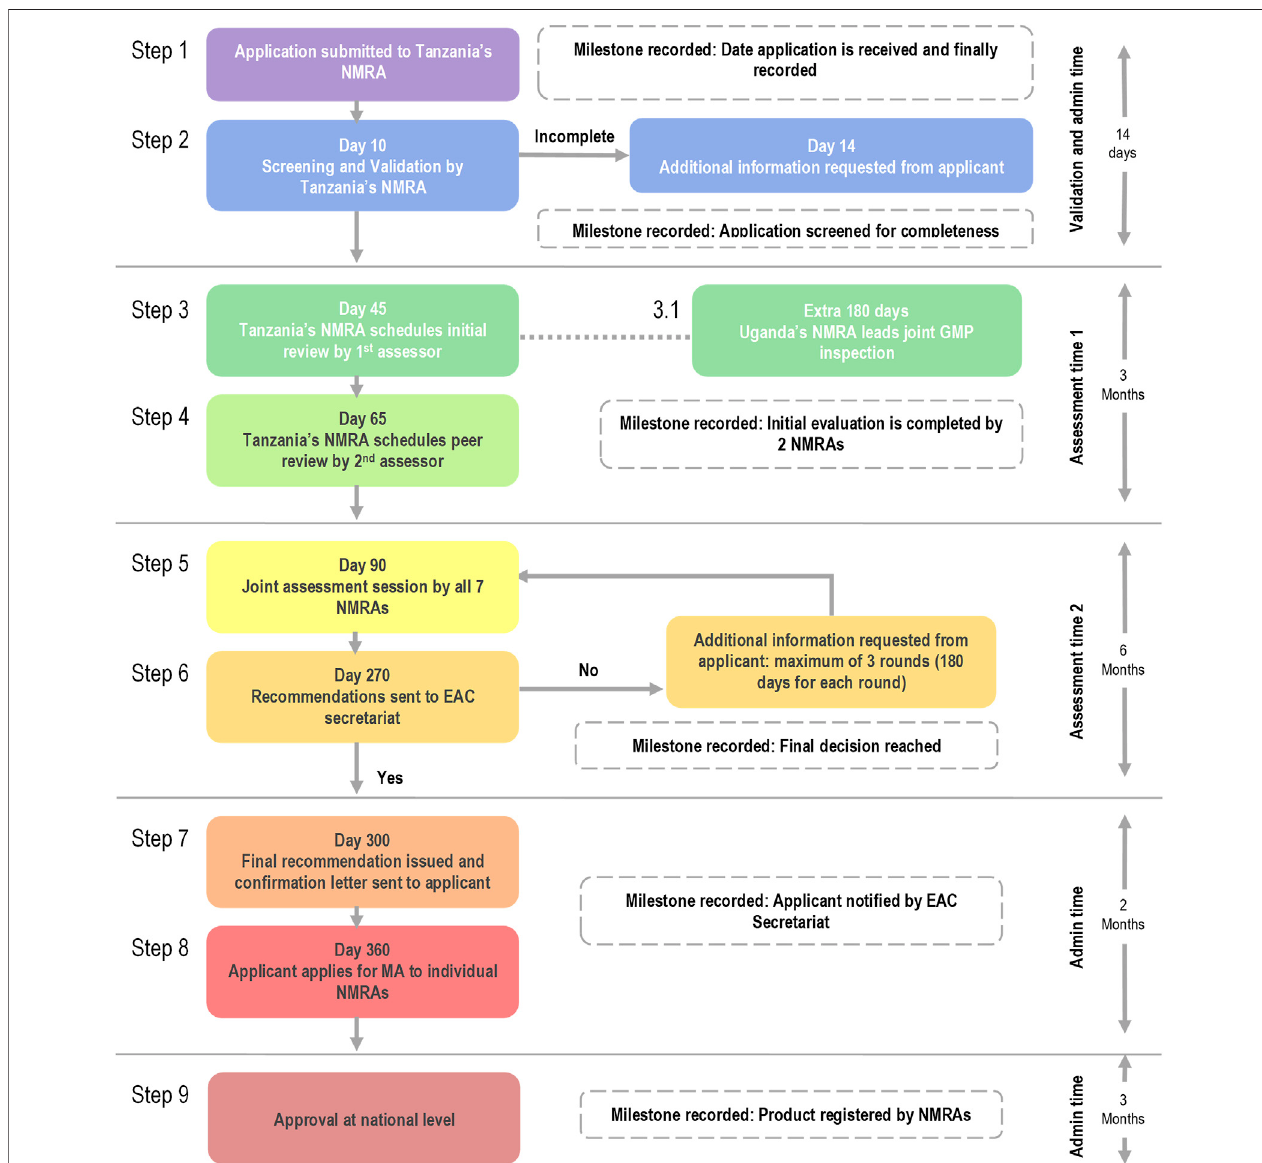
FIGURE 1 | Review process map and milestones for EAC joint assessment